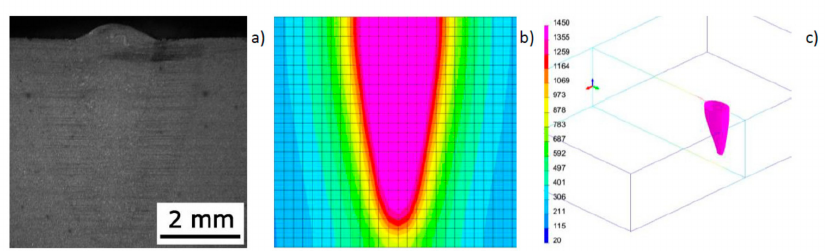
Figure 6. View of the macrostructure of the bead ( a ) in bead-on-plate welding tests performed on a 6.0-mm-thick sample of S355 steel using the Trumpf TruDisk 3302 disk laser at laser beam power of 1500 W and a welding speed of 8.3 mm / s; ( b ) cross-sectional view of the molten pool obtained as a result of numerical simulation; and ( c ) the 1450 ◦ C iso-surface.